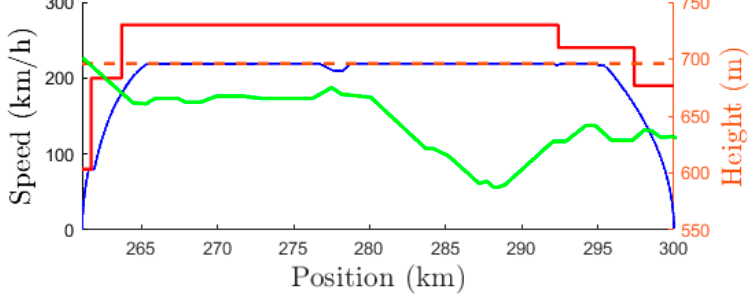
Figure 15. Standard driving speed profile for the commercial time in the Puertollano–Ciudad Real line section.